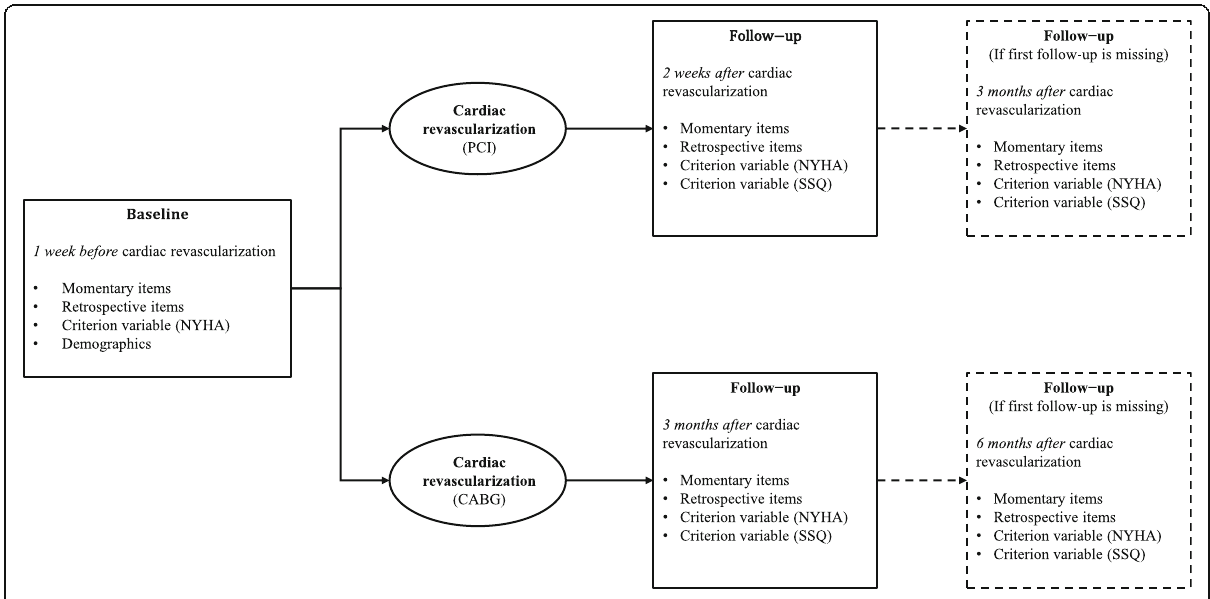
Fig. 1 Timeline of the study. Note. We only used the data of two time points: baseline and 2 weeks for PCI and baseline and 3 months for CABG. If these follow-up data were missing, data collected at 3 months (for PCI) and 6 months (for CABG) were used instead (see dotted line). NYHA = New York Heart Association functioning classification system [19, 20], SSQ = Subjective Significance Questionnaire